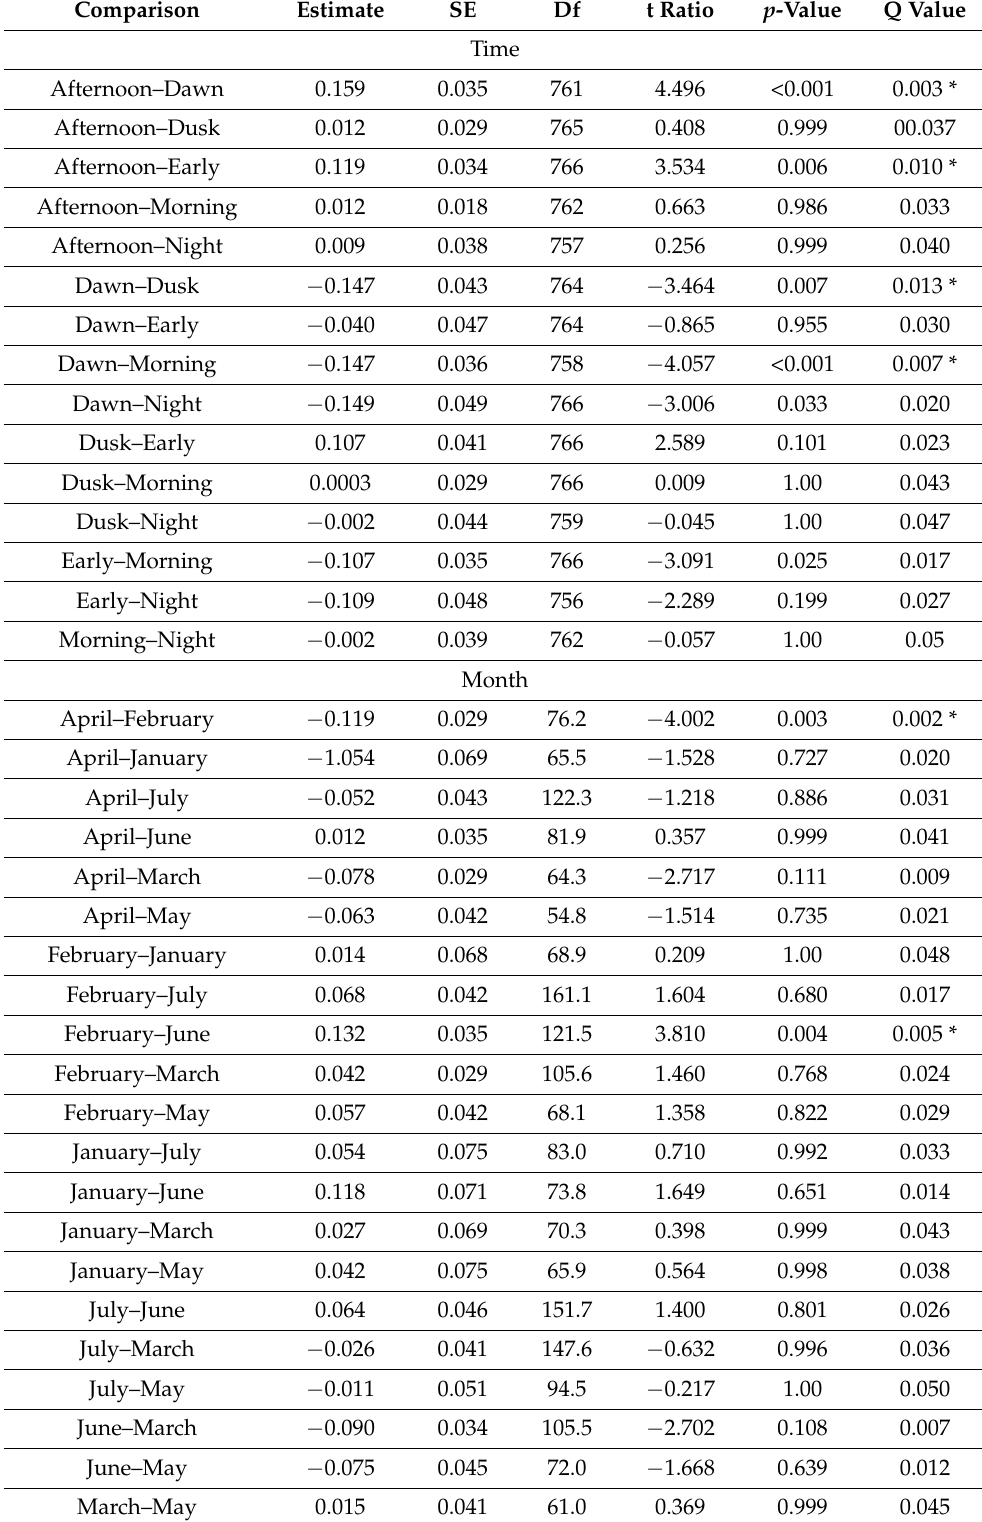
Table 3. Post-hoc comparison of indoor activity by time of day and by month of observation. Significant differences are marked with an